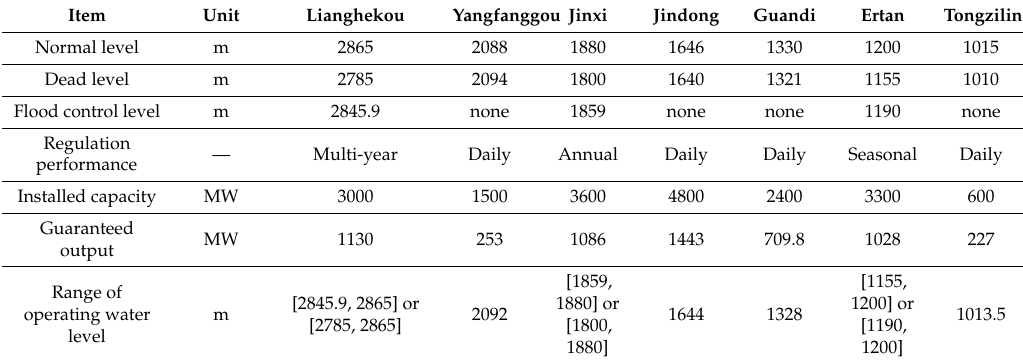
Table 1. Some basic parameters of the cascade reservoirs.